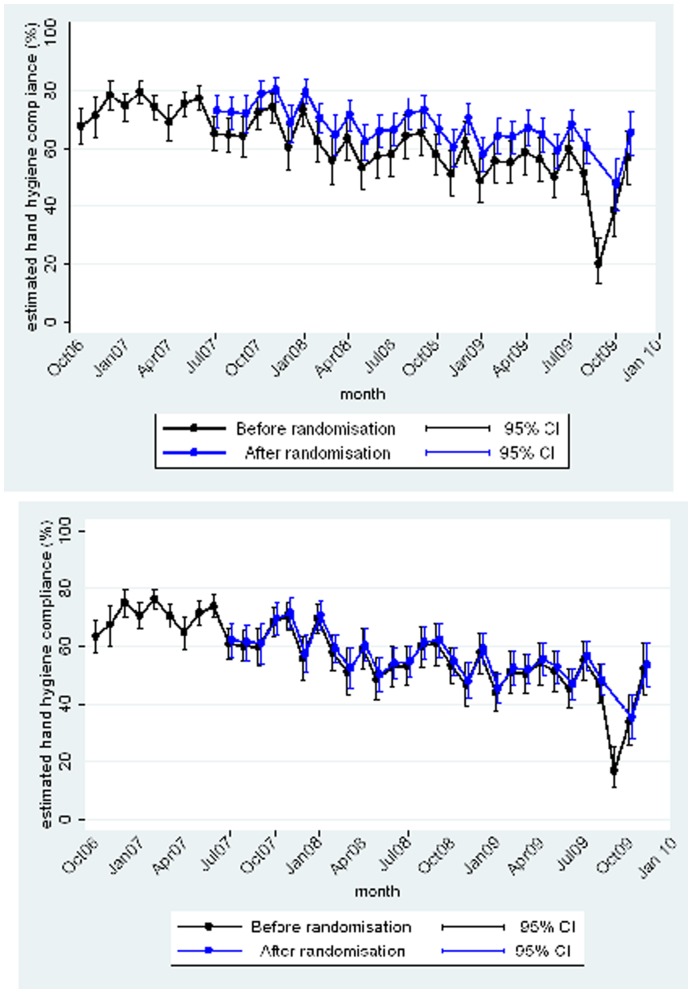
Hand-hygiene compliance in ITUs (upper panel) and ACE wards (lower panel): Intention-to-treat analysis.